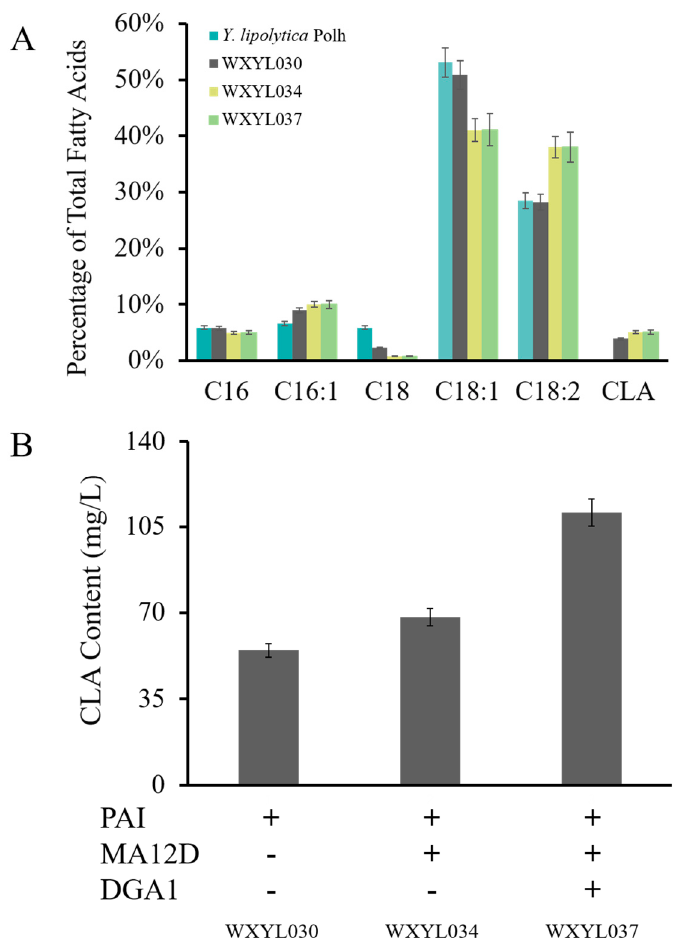
Figure 4. ( A ) Analysis of strains overexpressing PAI or/and MA12D, DGA1. Fatty acid distribution comparisons for WXYL030, WXYL034 and WXYL037 strain grown in shake flasks. ( B ) Conjugated CLA contents of strains were analyzed after 72 h of culture. Lipid samples were performed in triplicate.